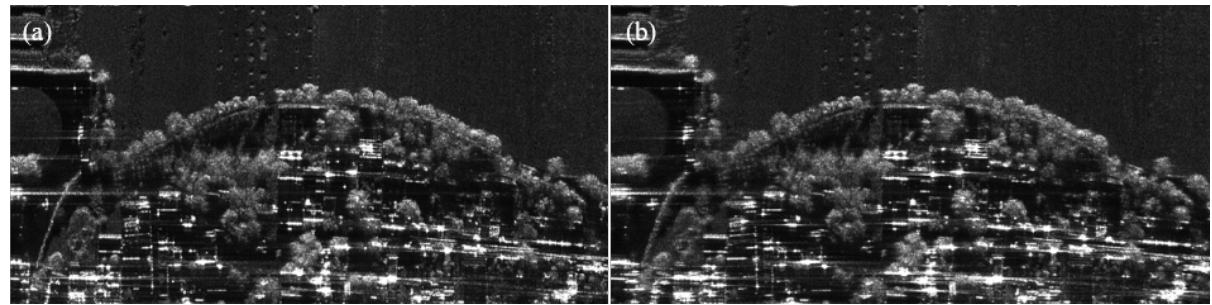
Figure 2. Autofocus imageries of scene type #2 by the non-parametric method ( a ) and parametric method ( b